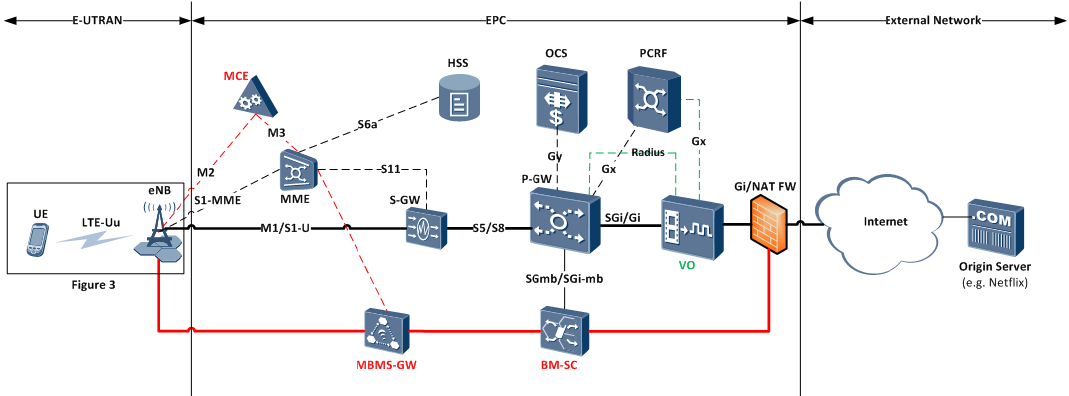
Figure 2. EPC network elements supporting mobile video delivery over 4G